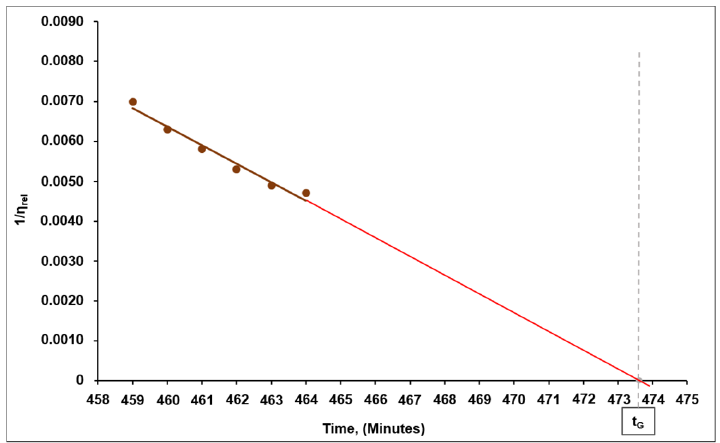
Figure 9. Gelation point (t G ) measurement, as exemplified by the solution of the p-(GAT- co -GA)-14 copolymer.